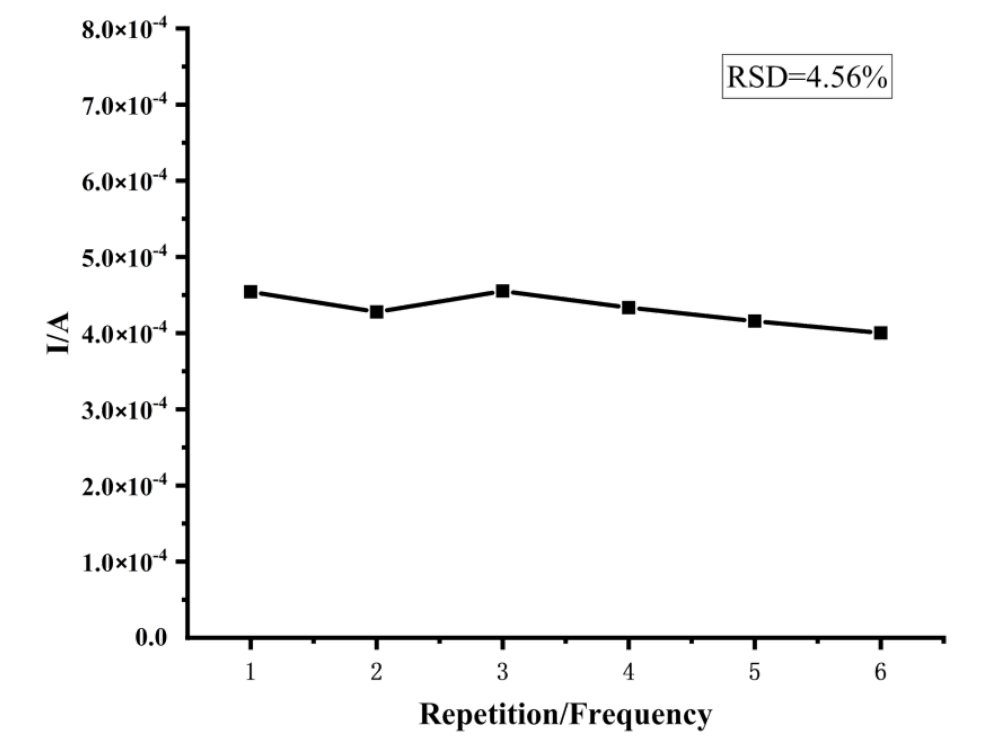
Figure 5. Results of the sensor repeatability test. Table 1. Test results of the sensor’s resistance to atrazine interference.